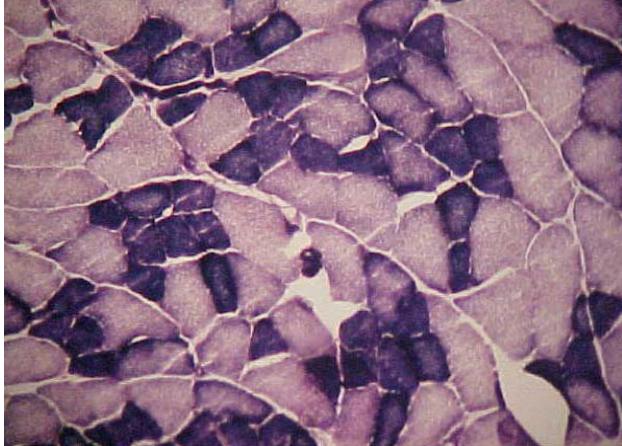
increase in oxidative activity (NADH x